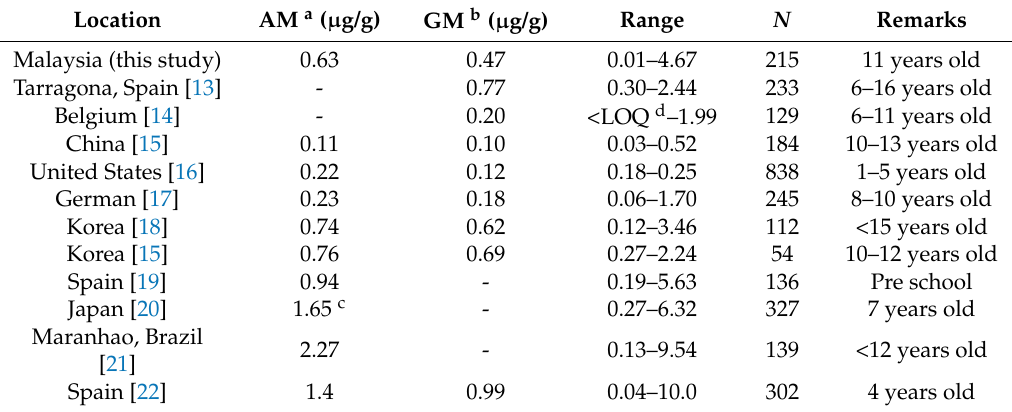
Table 2. Comparison of total mercury in hair (µg/g) among Malaysian children and other countries.